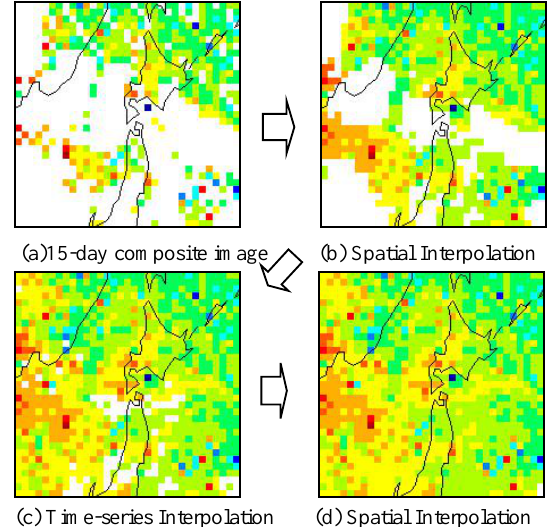
Figure 3. 3-stage interpolation of data missing due to the effects of cloud